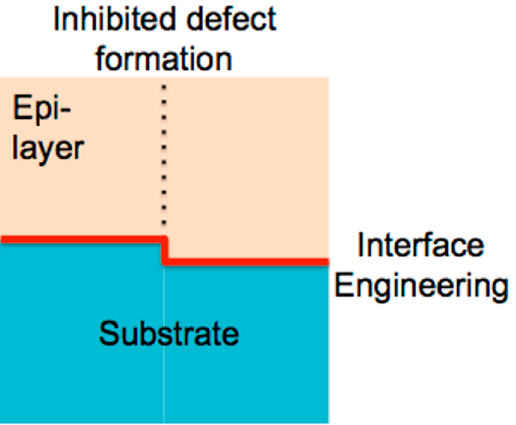
Figure 7. Design of interfaces for reducing defects in the epilayer by increasing formation energy.